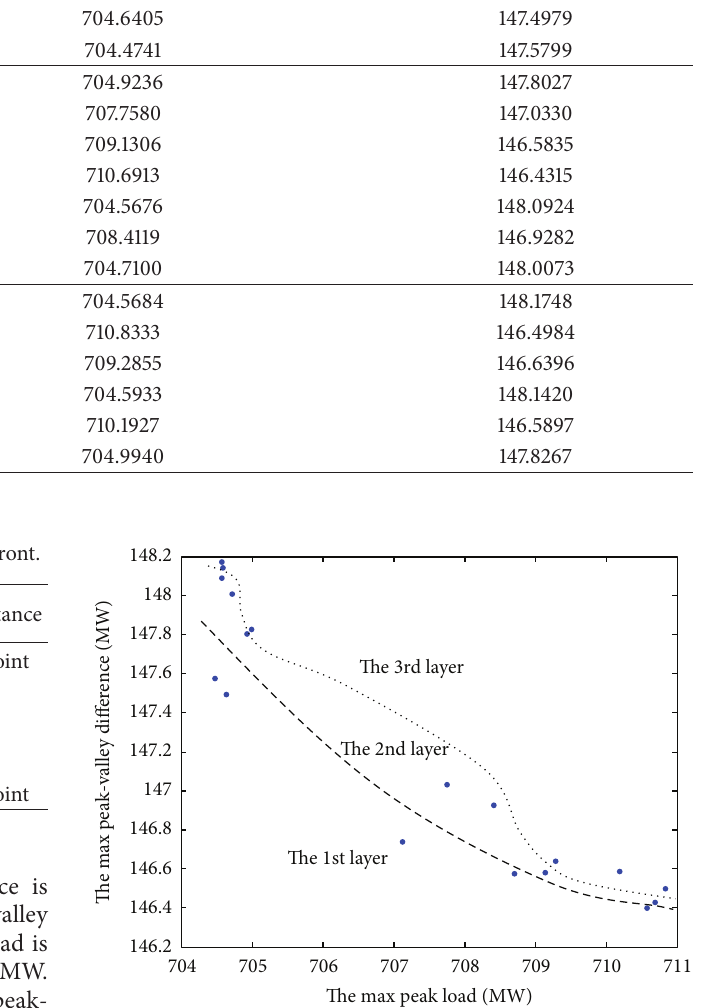
Figure 3: The distribution of individuals in the first three layers in objective